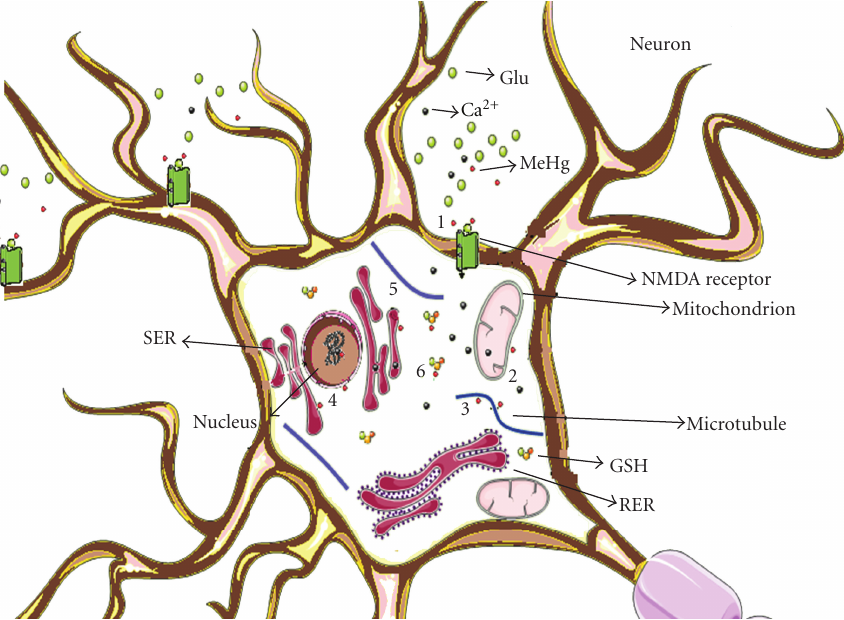
Figure 3: Schematic representation of possible mechanisms and cellular targets involved in the neurotoxicity MeHg-induced: (1) glutamate dyshomeostasis and Ca 2+ intracellular dysregulation; (2) mitochondrial dysfunction; (3) cytoskeletal disruption; (4) DNA damage; (5) SER dysfunction; (6) thiol depletion (especially glutathione). This scheme is merely representative and the scale of structures does not represent the real